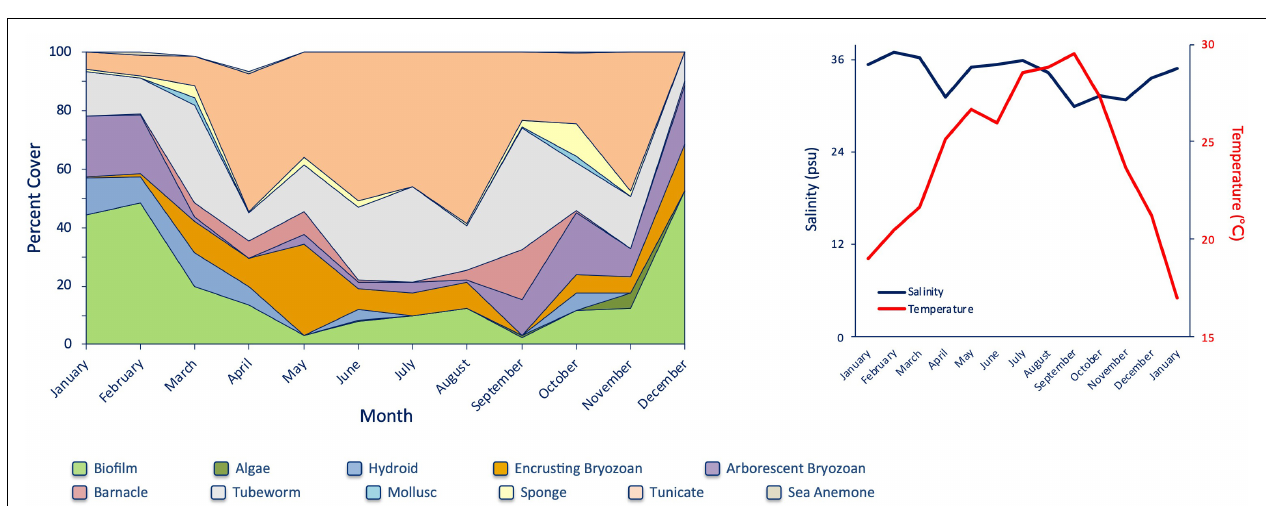
FIGURE 5 | Biofouling, temperature and salinity conditions at the large scale test site.